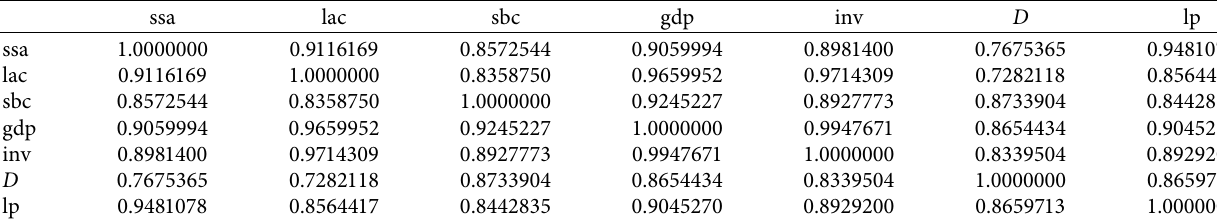
Table 8: Correlation test.